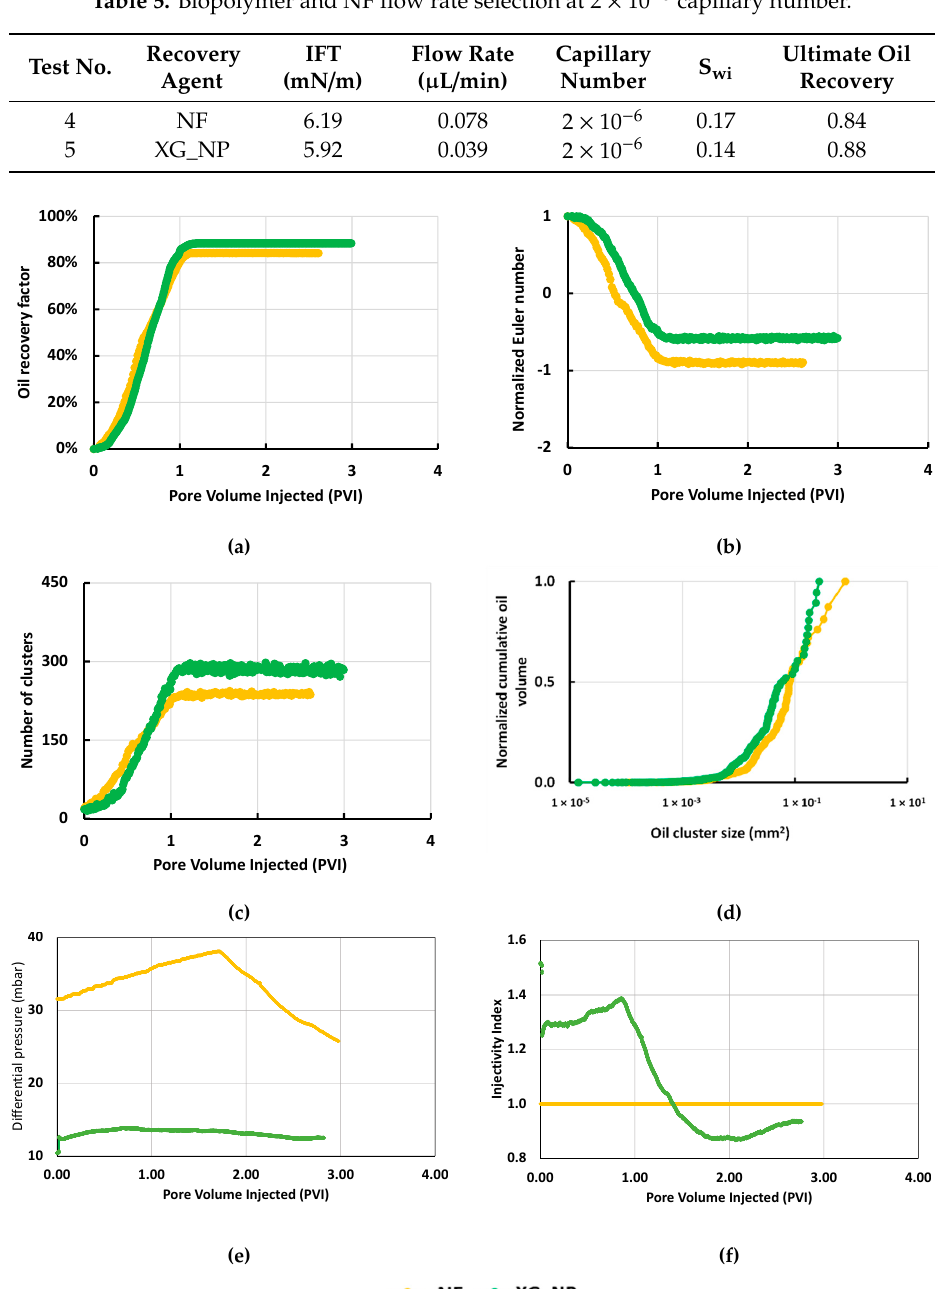
Table 5. Biopolymer and NF flow rate selection at 2 × 10 − 6 capillary number.